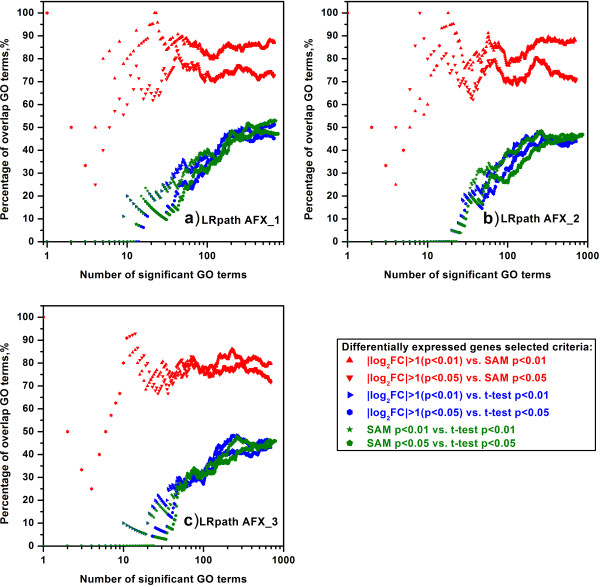
The concordance of significant GO terms enriched by LRpath within the same test site of AFX. The comparisons of significant GO terms enriched by LRpath were conducted within a) AFX_1; b) AFX_2; c)AFX_3. The same test site of the same platform enrichment which used the gene lists derived from different statistical methods. Two DEGs lists generated by fold change ranking and two DEGs lists generated by SAM and two DEGs lists generated by t-test were input in LRpath to get significant GO terms (FDR < 0.25). See notes under Figure 4 for more information. The concordance of two significant GO terms lists derived from two DEGs selected methods was compared on the same p-value cutoff.